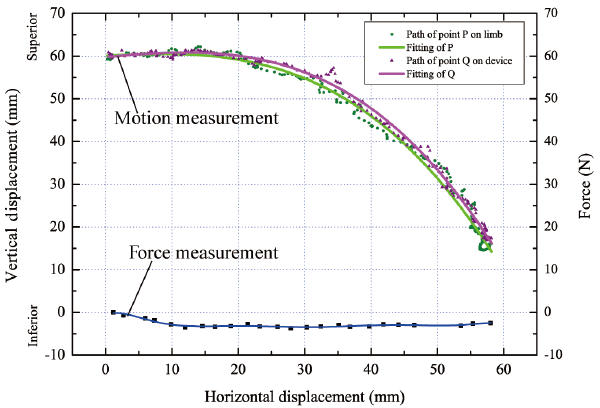
Figure 14. Motion comparison between measuring points on hu- man and exoskeleton & corresponding force